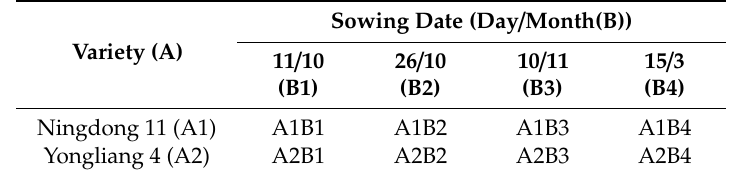
Figure 1. In temperature and rainfall during the three years of the experiment. Table 2. Experimental design scheme for 2013–2014.